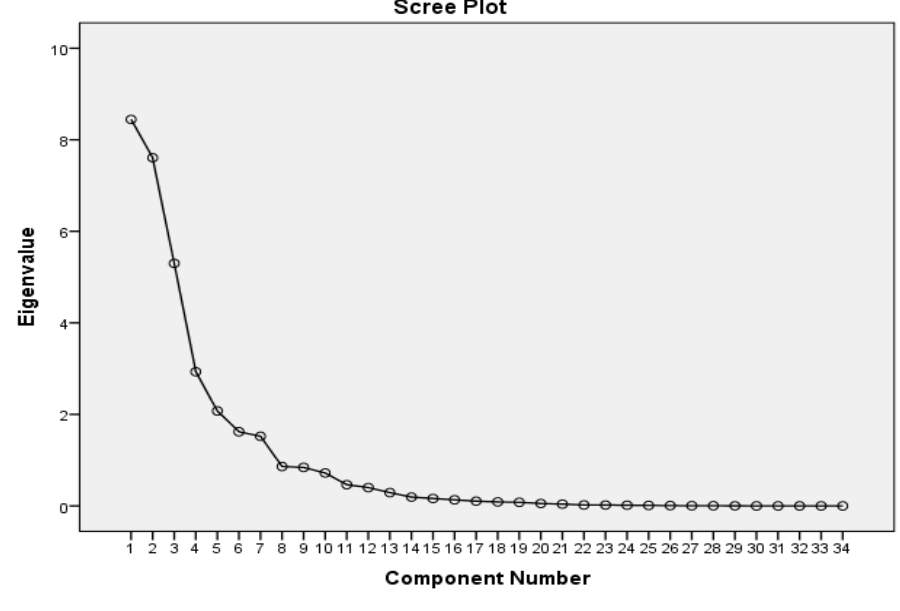
Figure 1. Scree Plot. Source: Authors’ Compilation.